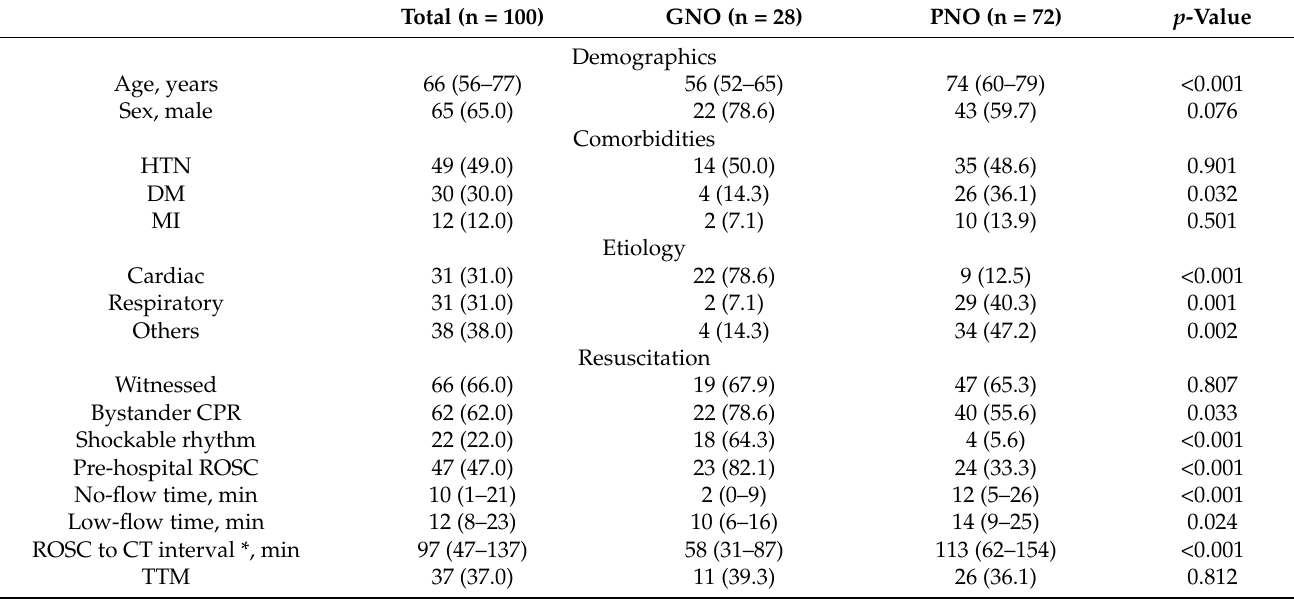
Table 3. Age and low-flow time were independently associated with neurological